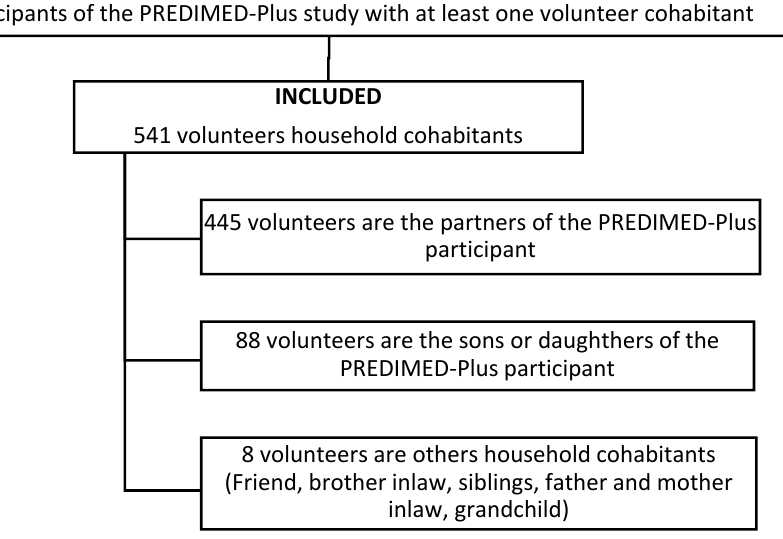
Figure 1. Flow chart of the study.